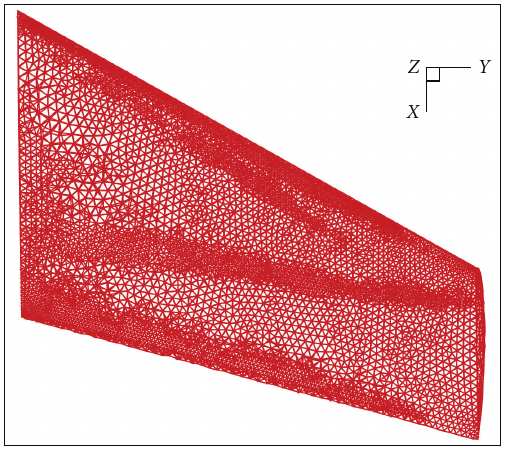
Figure 5: Adapted surface mesh of ONERA M6